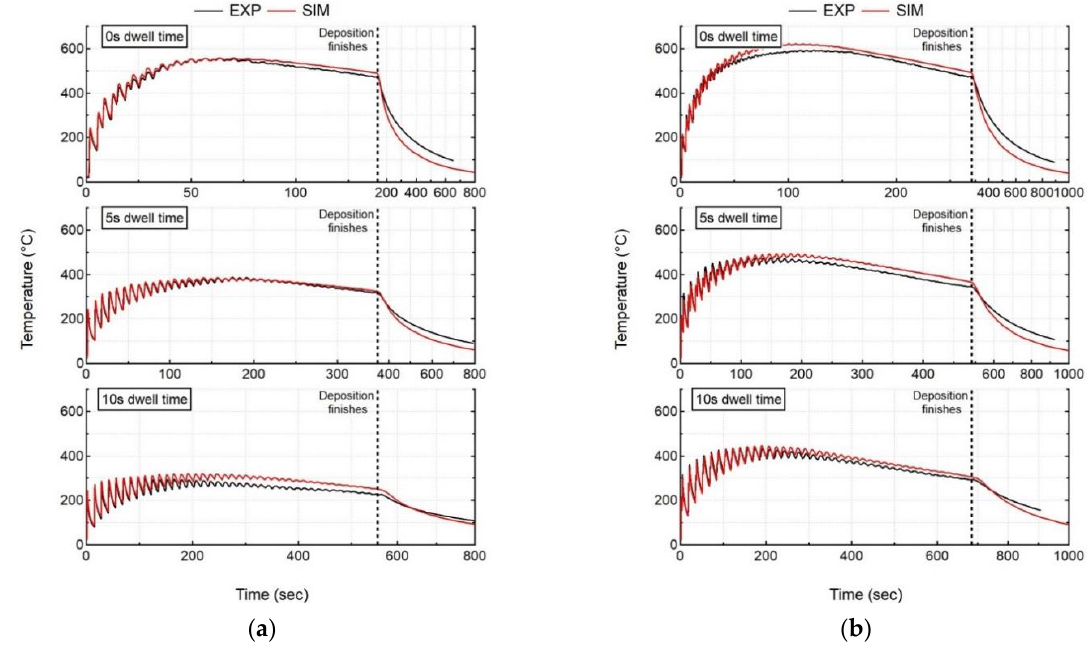
Figure 5. Comparison of numerical results (SIM) with recorded in situ thermal history (EXP) of thermocouple 1 for all cases ( a ) single-bead wall, ( b ) double-bead wall.